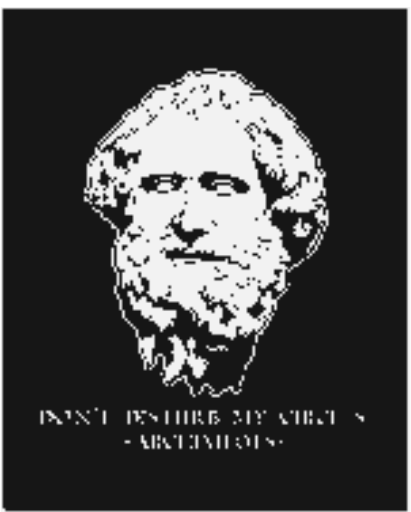
Figure 31. Archimedes using FCM.